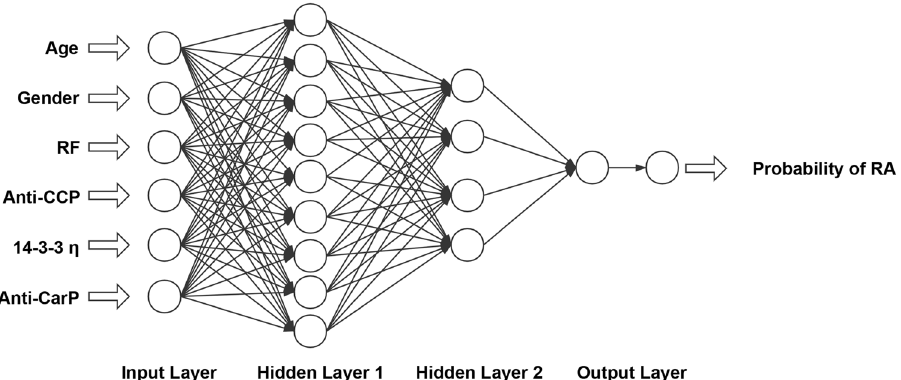
Figure 2. Computational structure of the artificial neural network (ANN). The inputs are age, sex, rheumatoid factor (RF), anti-CCP, 14-3-3η, and anti-CarP. This network has 2 hidden layers, one with 9 neurons and the other with 4 neurons. The output shows the probability of RA under this model.